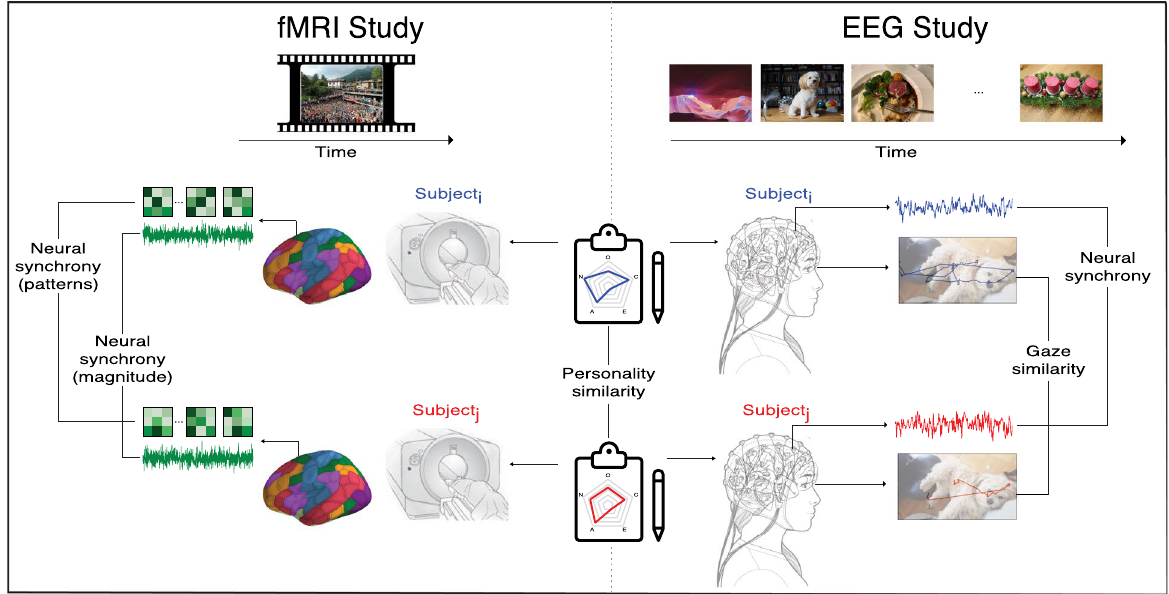
Figure 1. Experimental paradigms. Subjects completed personality questionnaires and viewed content while neural data were acquired. Inter-subject personality similarity was calculated using Euclidean distance between subjects’ personality traits (center). In the fMRI study (left), subjects watched a series of videos while being scanned. Temporal fluctuations in spatially-averaged response magnitudes and in spatially-distributed response patterns were extracted from each brain region and subject. These time series were used to compute pattern- and magnitude-based neural synchrony measures for each unique dyad. In the EEG study (right), subjects saw a series of images while data were acquired from their brain. After preprocessing—filtering and artifact removal— the data from pairs of subjects were linearly projected to a transformation that maximizes the correlation between the two individuals in component-space. Averaging the correlation between each pair of components, and, following, across all images viewed, yields a quantitative estimation of the synchrony among the dyad. Simultaneous acquisiton of eye tracking data allowed for parallel comparison of each individual’s scanpath and an estimation of the similarity in viewing trajectories. The images depicted in the figure are different from those shown to participants and were chosen as copyright-free